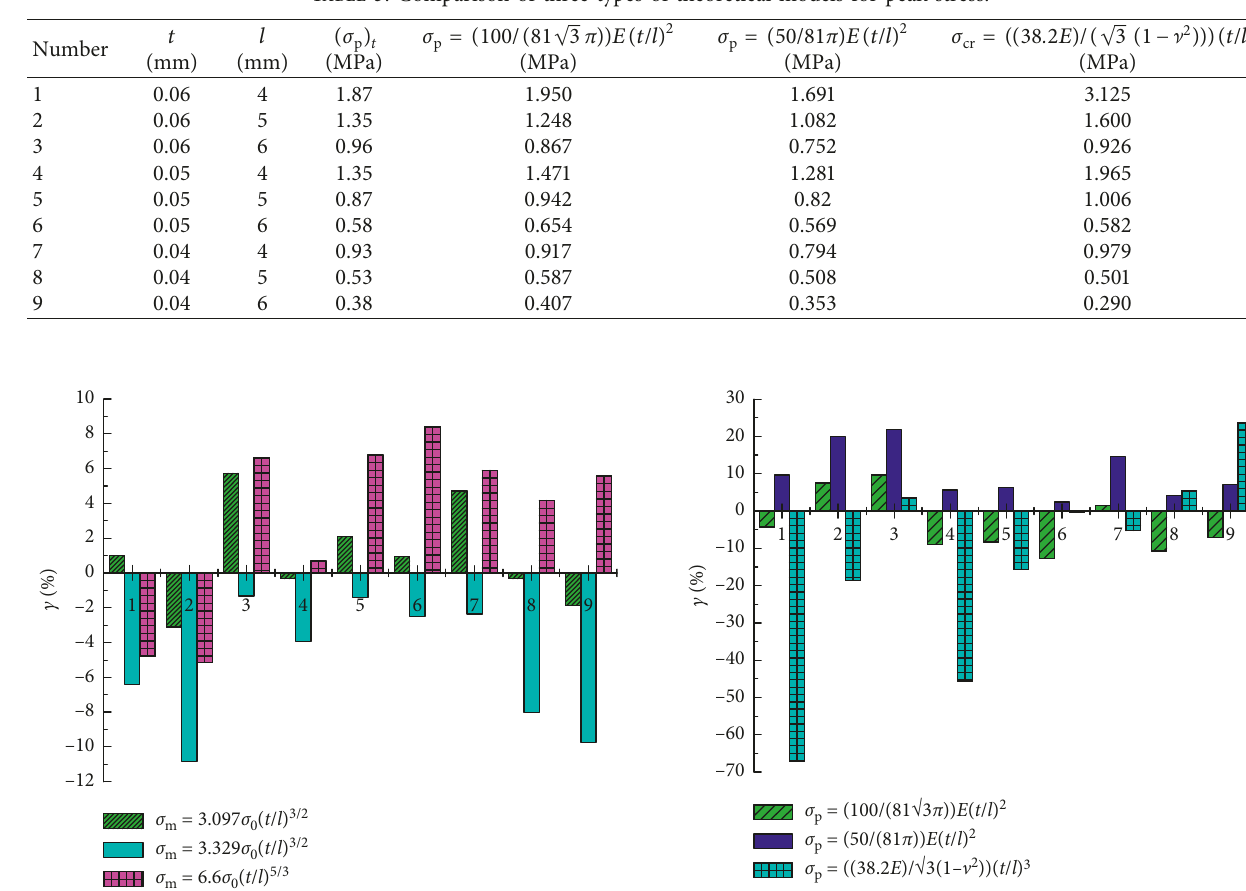
Table 3: Comparison of three types of theoretical models for peak stress.